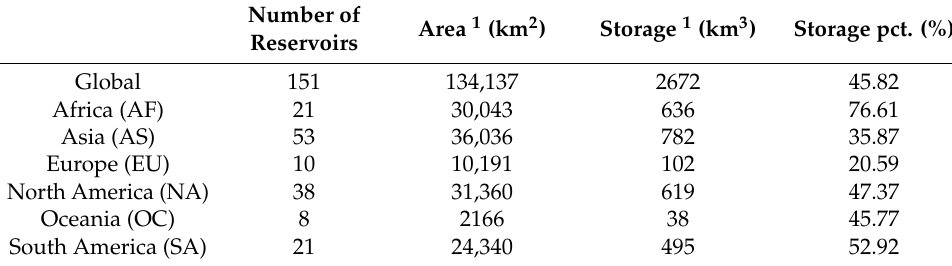
Table 1. Distribution and attributes of the 151 man-made reservoirs in this product.